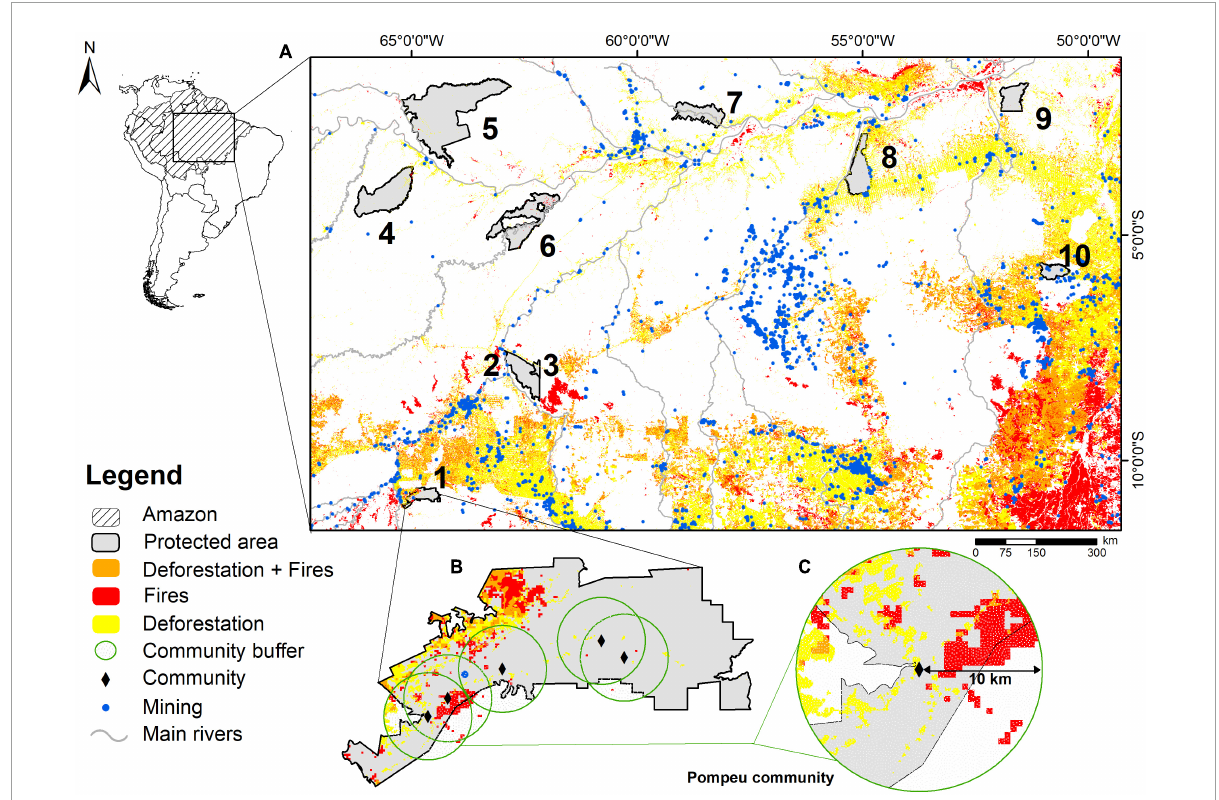
FIGURE1 (A) Location of the 10 protected areas studied and their environmental threats context. Gray polygons correspond to protected areas: 1 Rio Ouro Preto RESEX; 2 Humaitá FLONA; 3 Jiahuí TI (smaller polygon overlaping Humaitá FLONA); 4 Tefé FLONA; 5 Amanã RDS; 6 Piagaçu-Purus RDS; 7 Uatumã RDS; 8 Tapajós FLONA; 9 Caxiuanã FLONA; 10 Tapirapé-Aquiri FLONA. Environmental threats: in yellow—accumulated deforestation from 1988 to 2019; in red—2000–2019 consolidated burned areas; in orange—deforestation and fires overlap; in blue—legal and illegal mining in 2020. (B) Example of the estimates of environmental threats at the community level in Rio Ouro Preto RESEX. (C) Detailed Pompeu community example. Some communities’ 10 km radius overlapped and/or are beyond the PAs’